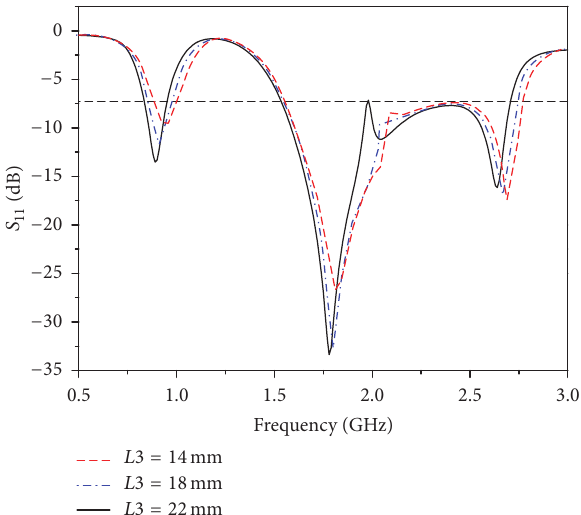
Figure 5: Reflection coefficient of the proposed antenna for different value of L